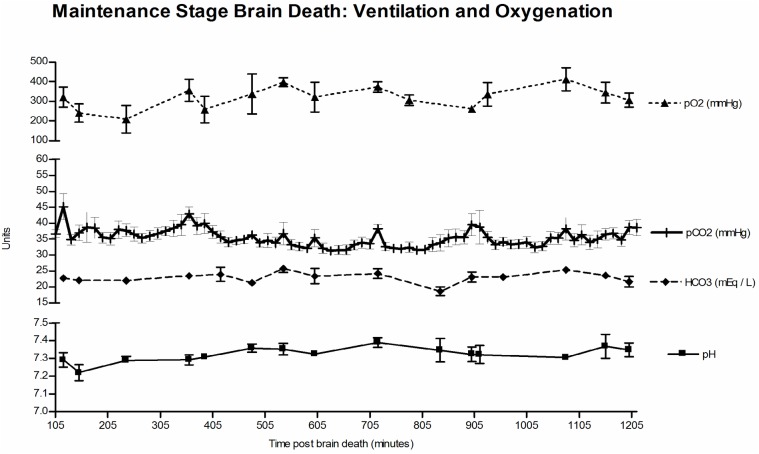
Maintenance of brain death—Ventilation and oxygenation.Using by following serial ABGs and making appropriate ventilator adjustment, we were able to maintain adequate oxygenation and ventilation throughout brain death.